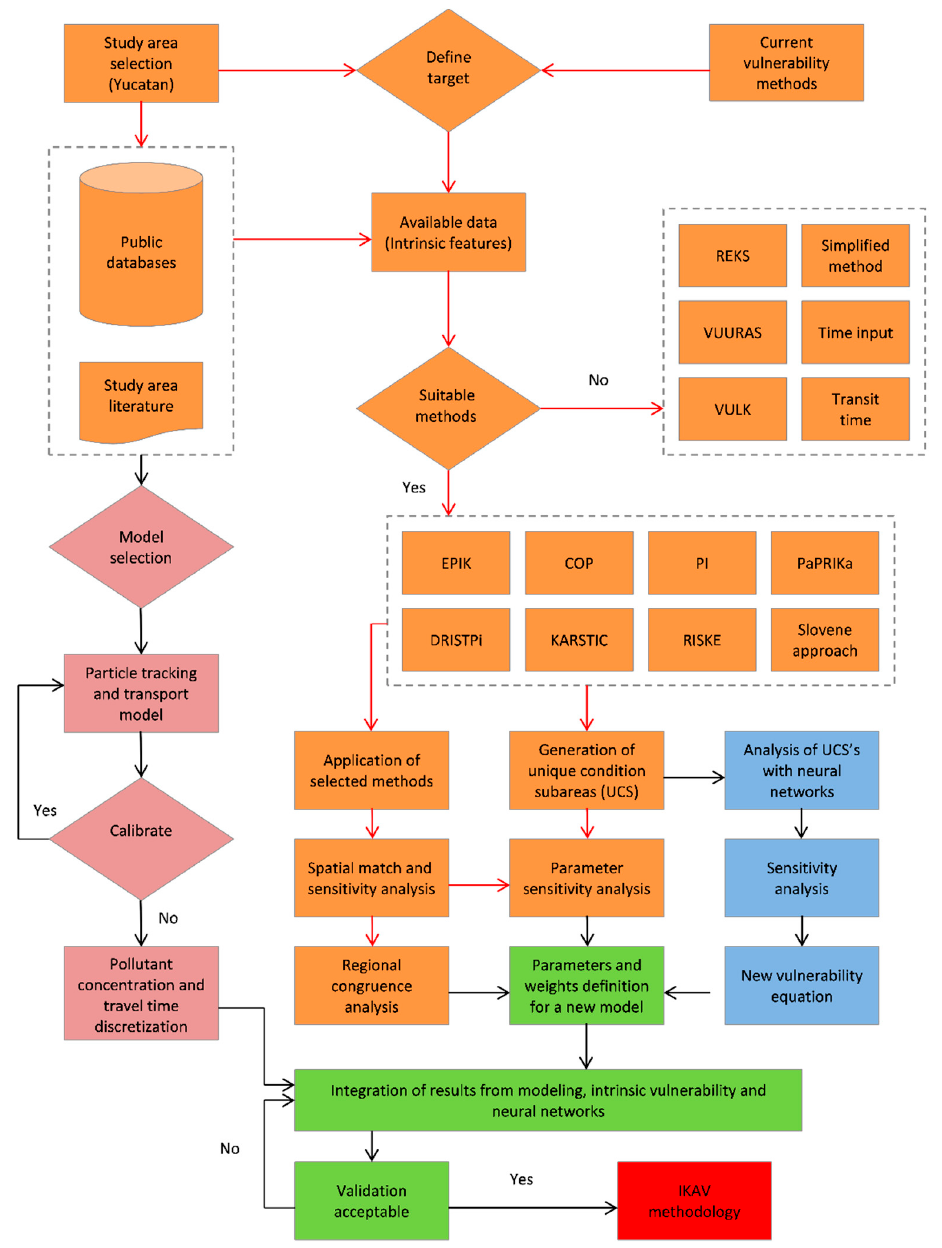
Figure 1. Workflow for the development of a new integrated approach; red arrows follow the scope of this work. Unsuitable methods are those demanding data not available for the study area.